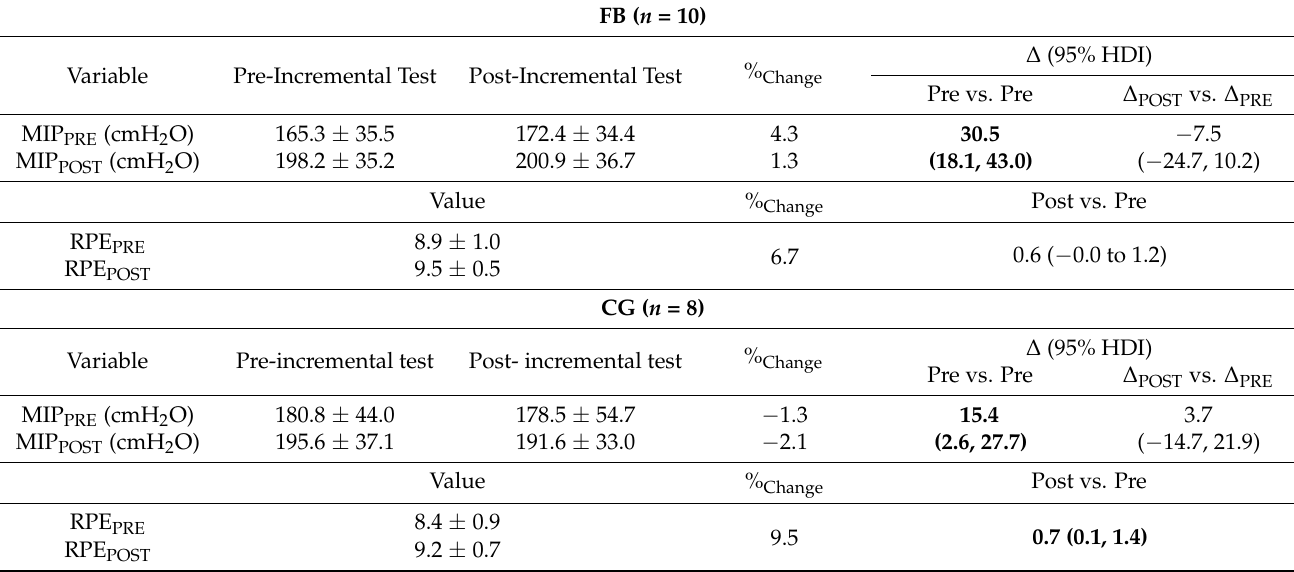
Table 5. Within-group pre- and post-test differences in MIP and RPE values. FB ( n = 10)